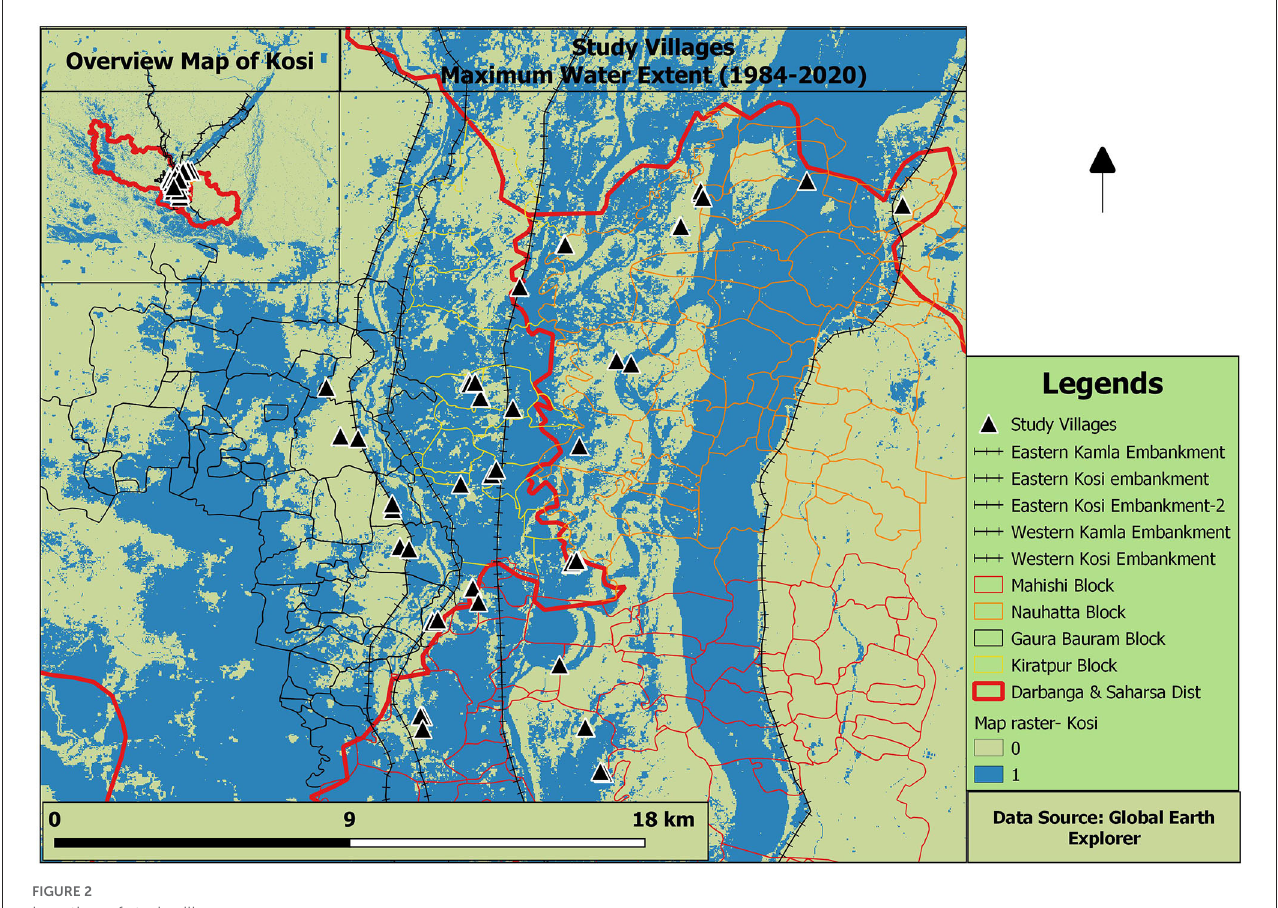
FIGURE2 Location of study